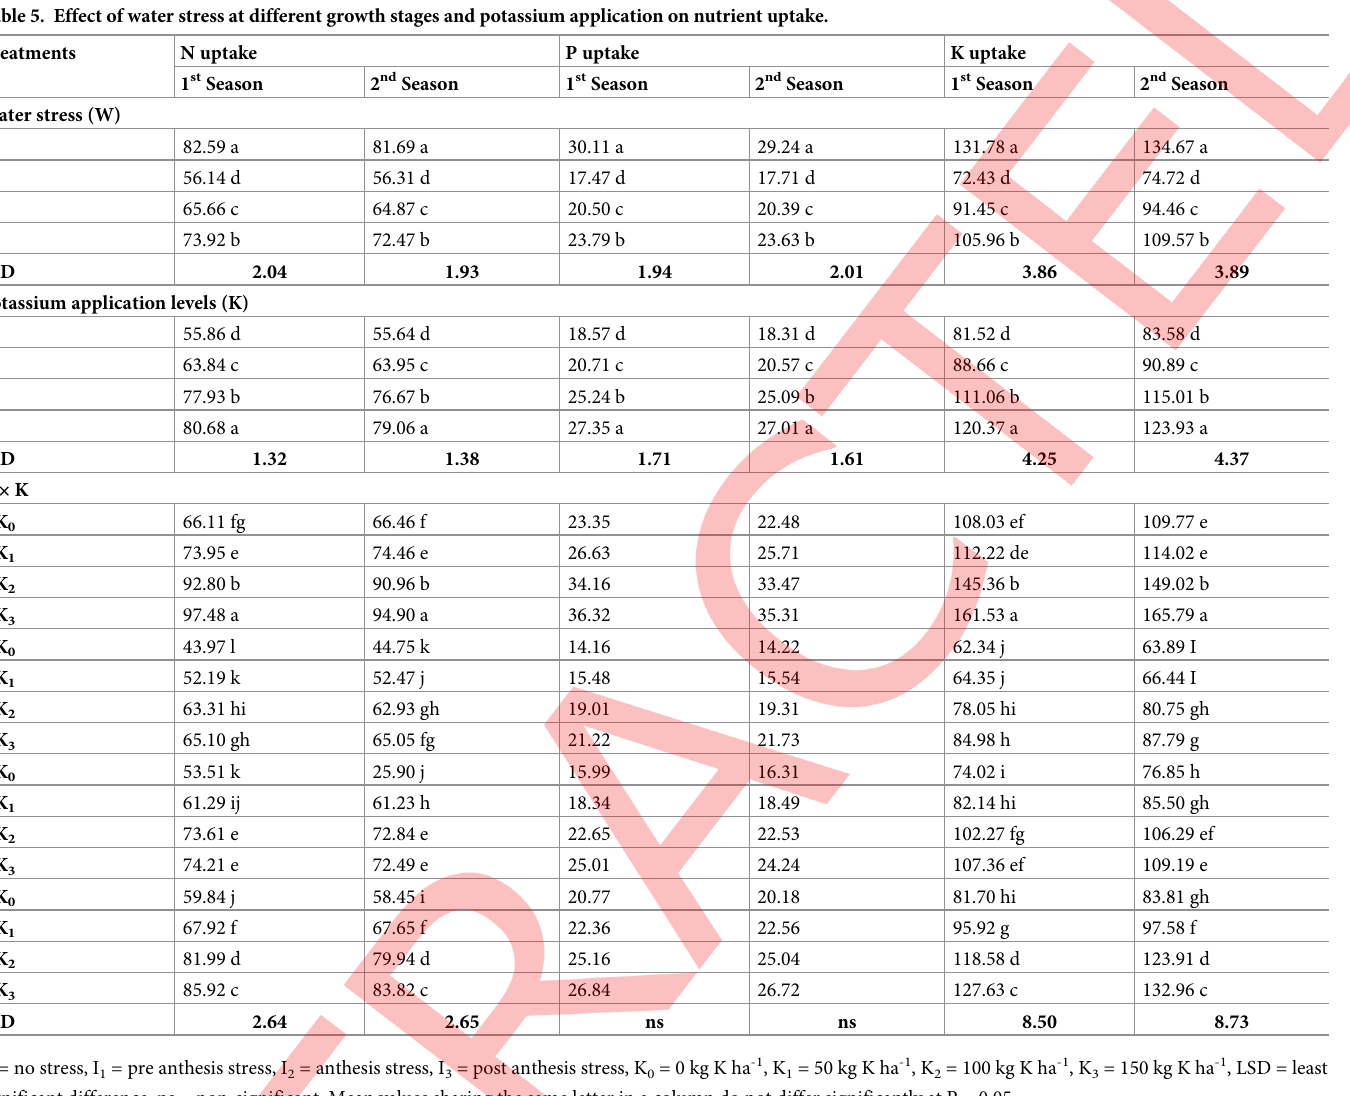
Table 5. Effect of water stress at different growth stages and potassium application on nutrient uptake.